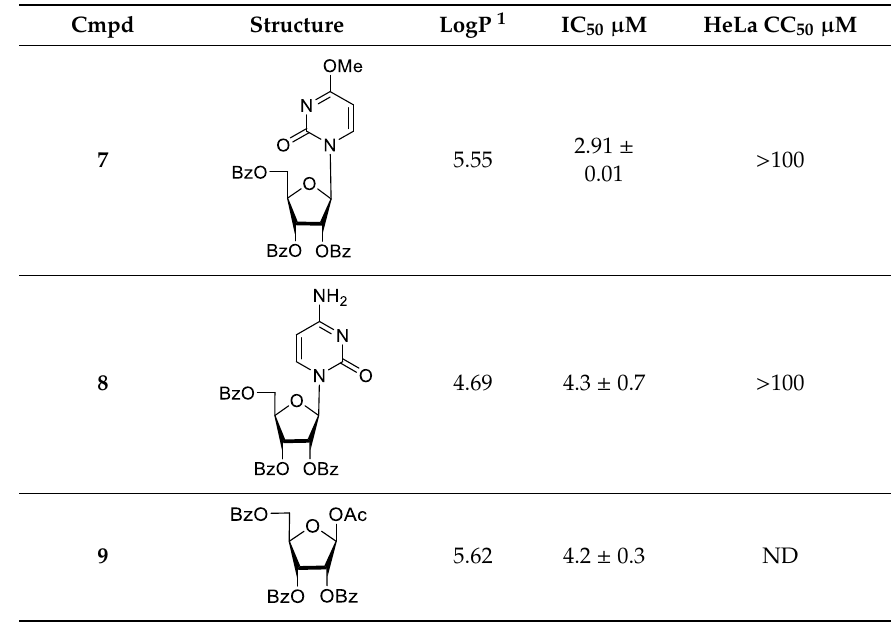
Figure 1. Dose-dependent action of the lipophilic pyrimidine nucleosides on HeLa cell viability measured in the EZ4U assay.